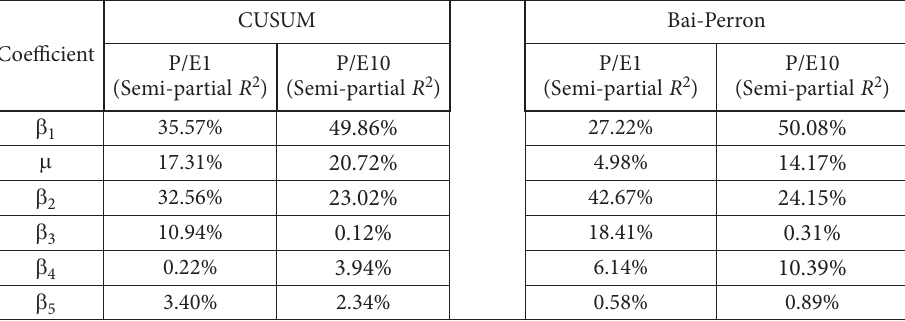
Table 5. Semi-partial R 2 for each explanatory